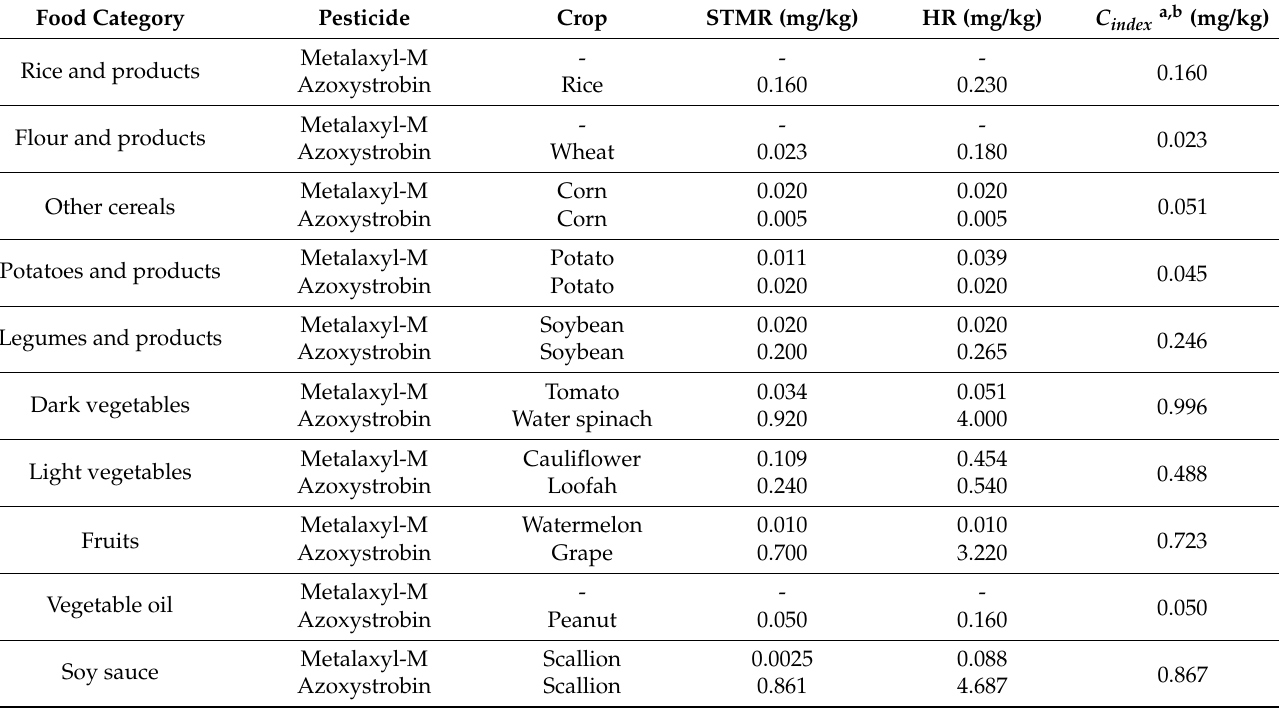
Table 2. Food categories and residue data screened for cumulative risk